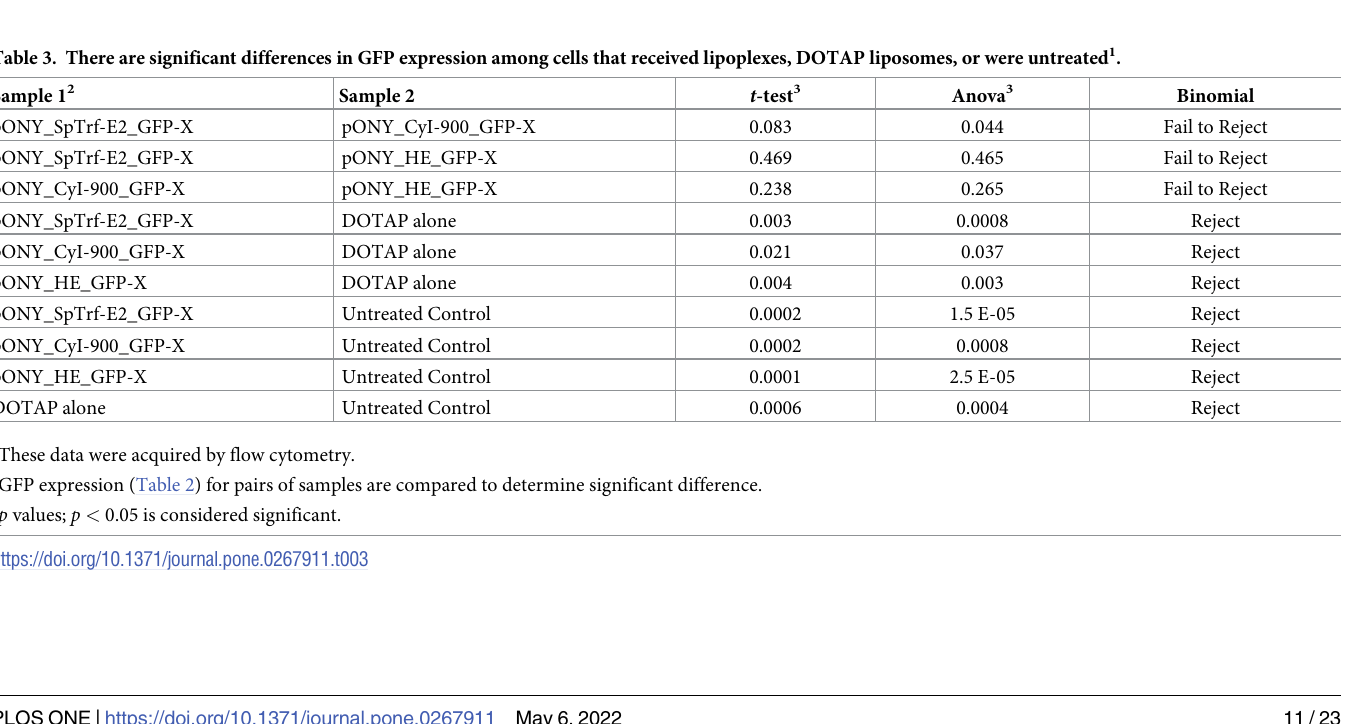
Table 3. There are significant differences in GFP expression among cells that received lipoplexes, DOTAP liposomes, or were untreated 1 .